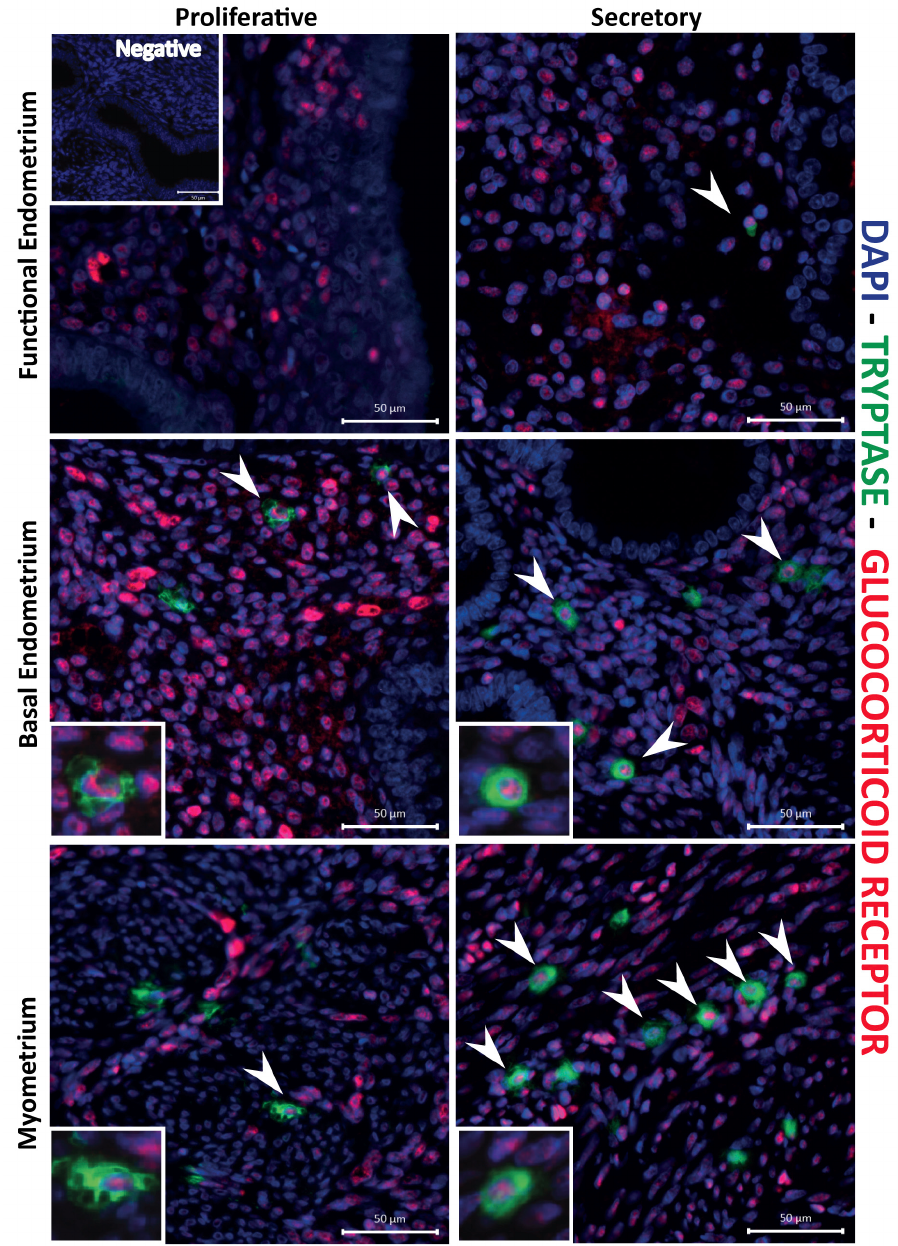
Figure 6. Uterine mast cells in the endometrium and myometrium are immunopositive for glucocorticoid receptor. Mast cell nuclear glucocorticoid receptors (GR; red staining) was detected during the proliferative and secretory phase, throughout the myometrium, functional and basal endometrial and layers. The images are representative of results in proliferative (n=5) and secretory (n=5) phase samples.